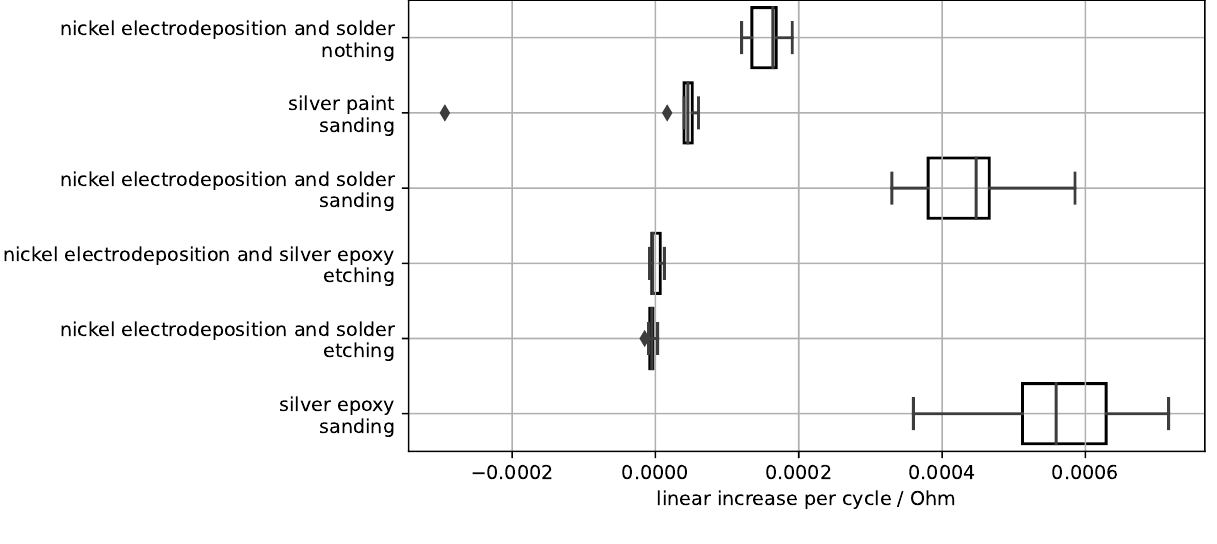
Figure 7. Linear irreversible increase of the resistance per cycle.